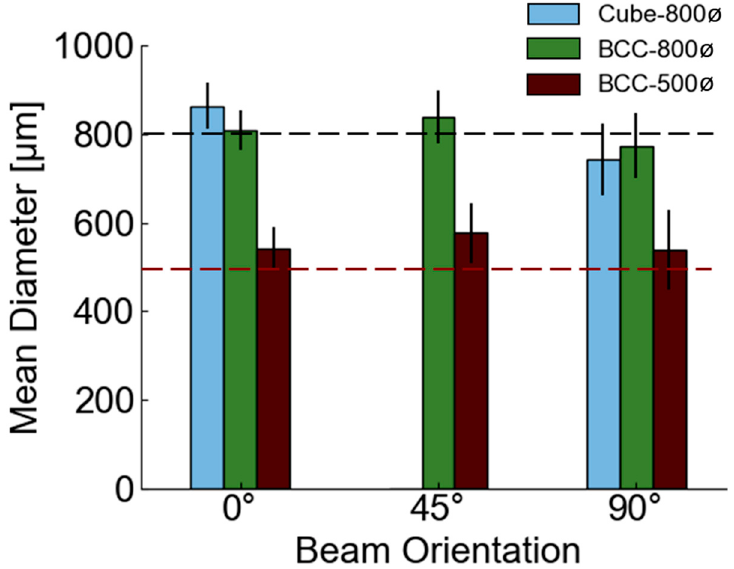
Figure 9. Measured mean beam diameters with standard deviation bars. Black dotted line provides a reference for 800 µm intended beam diameters, while the lower red dotted line provides a reference for 500 µm intended beam diameters.